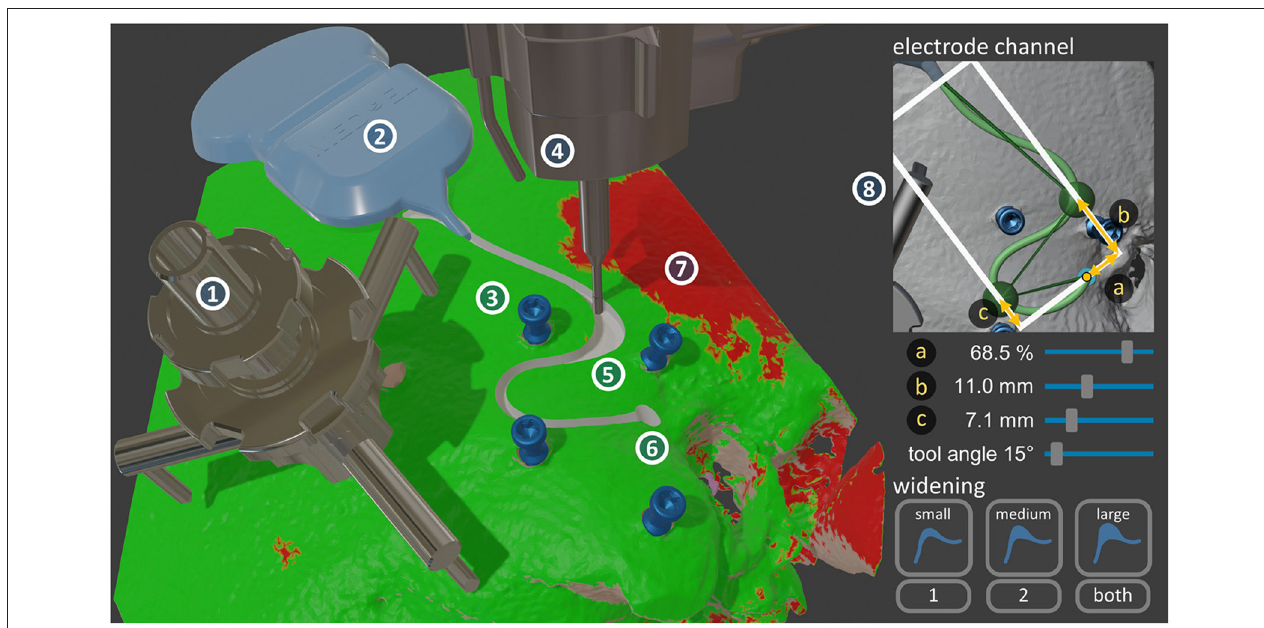
FIGURE 3 | Left: The custom-developed surgery planning software, implemented in Blender. The visualized objects are the HEARO Patient Marker Attachment tripod (1), the silicone template of the receiver-stimulator (2), the four HEARO Fiducial Screws (3), the end-effector with the milling cutter (4) in the planned electrode lead channel widening (5), and the planned drill access hole to the middle ear (6). All these structures reside on the patient’s reconstructed temporal bone, onto which a red-green map is overlayed showing where the bone thickness is sufficient to place a channel plus safety margin (7). Right: A possible user interface implementation for the planning workflow